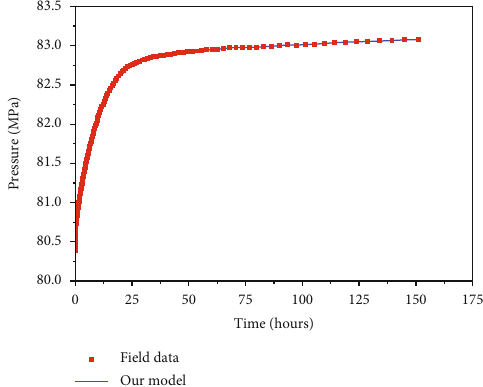
Figure 16: Pressure history match of the fi eld data.